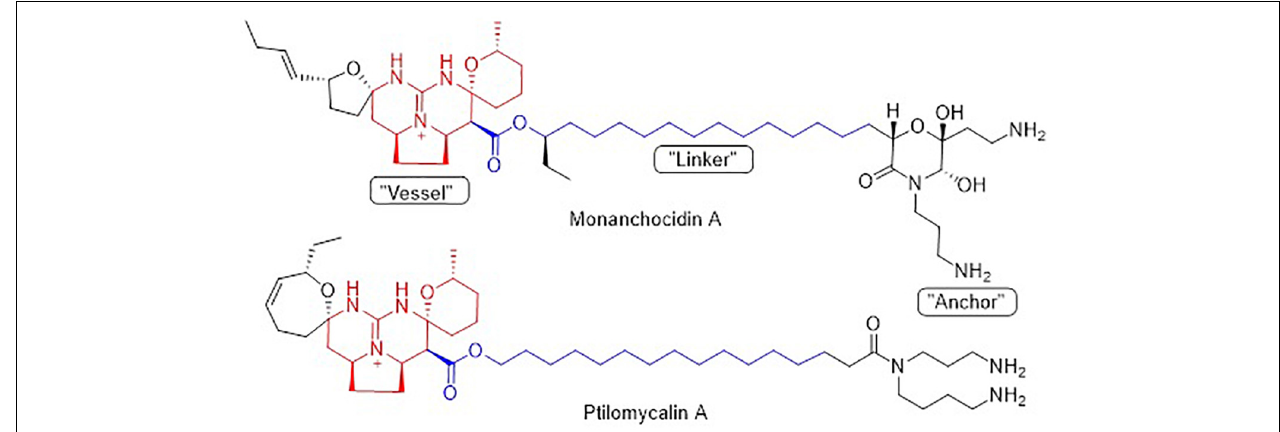
FIGURE 6 | Structural similarity between monanchocidin A and ptilomycalin